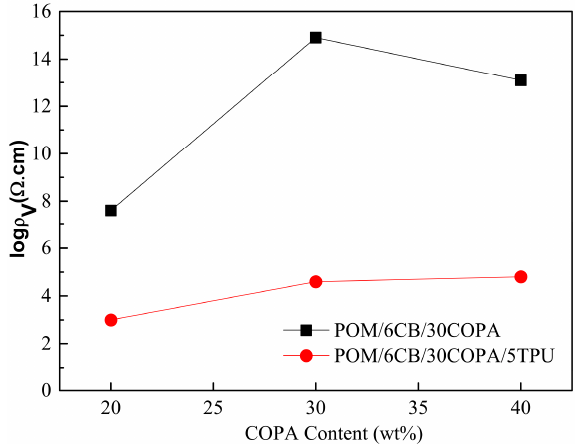
Figure 6. Electrical resistivities of the composites containing different amounts of COPA with and without minor TPU component.